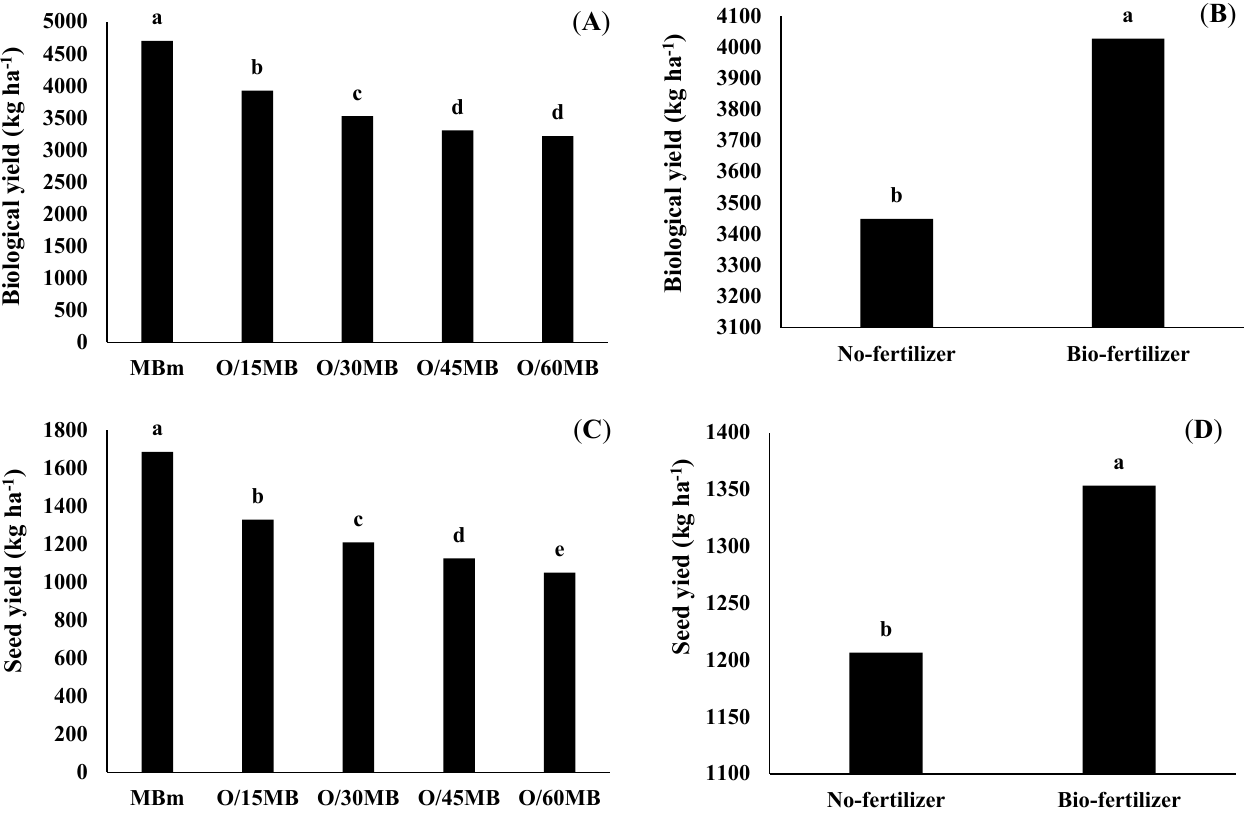
Figure 7. The biological and seed yield of mung bean in different cropping patterns ( A , C ) and fertilizer application ( B , D ). MBm: mung bean monocropping; O/15MB: intercropping ratios of 100% marjoram + 15% mung bean; O/30MB: 100% marjoram + 30% mung bean; O/45MB: 100% marjoram + 45% mung bean; O/60MB: 100% marjoram + 60% mung bean. Different lower-case letters above the bars indicate significant ( p ≤ 0.05) differences.